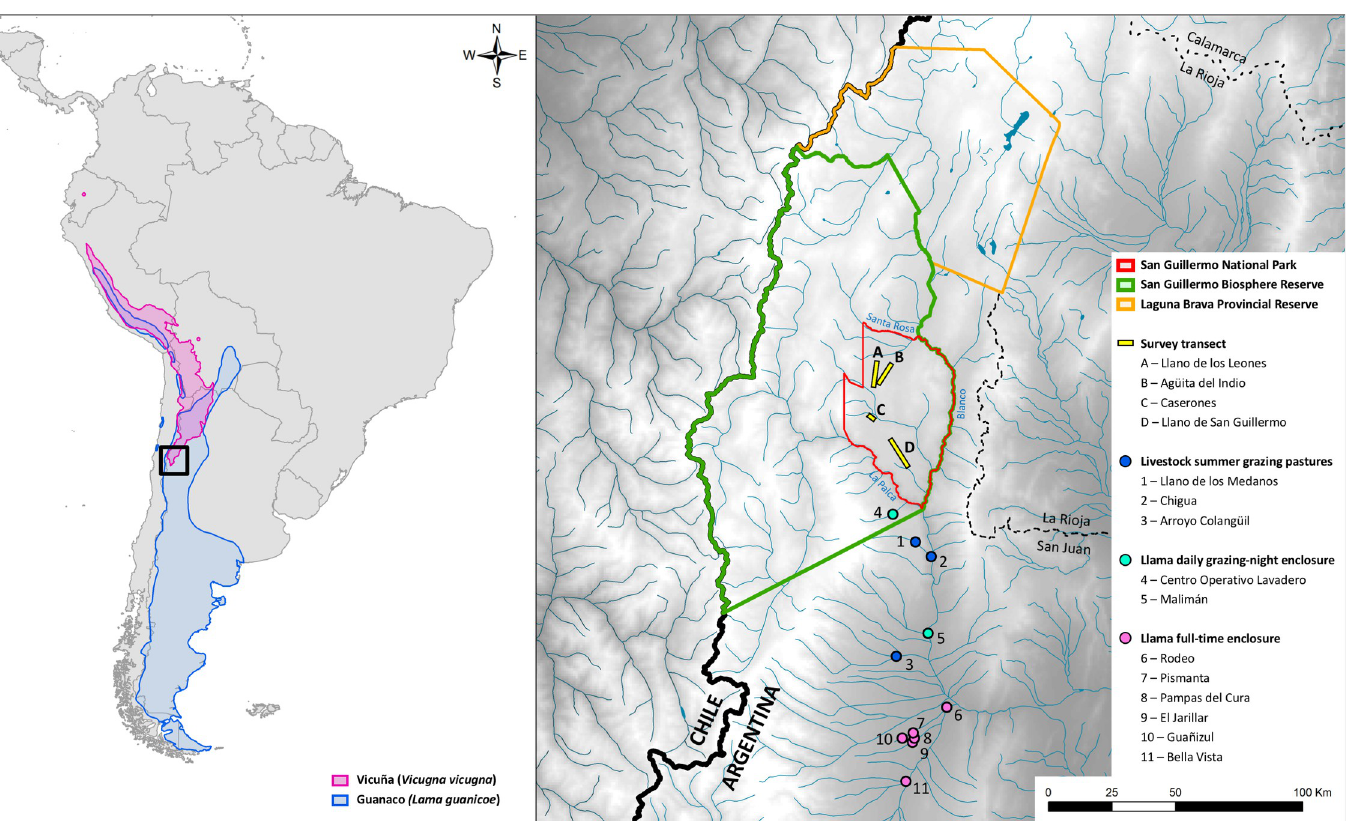
Fig 1. Location of San Guillermo National Park and study transects in relation to the natural distribution of vicu ñ as and guanacos and nearby farms and grazing areas of livestock and recently introduced llamas.